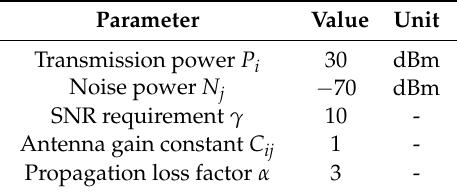
Table 1. The parameters of the realistic wireless communication